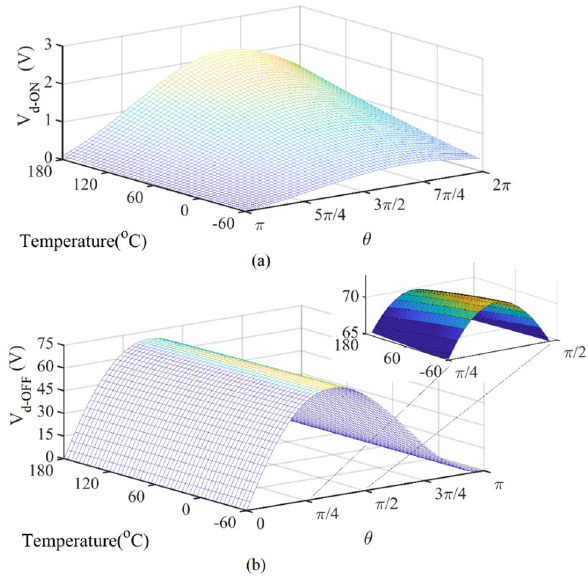
Figure 14. V d versus temperature and Ɵ ( a ) in the ON-state (π < Ɵ < 2π), ( b ) in the OFF-state (0 < Ɵ < π).